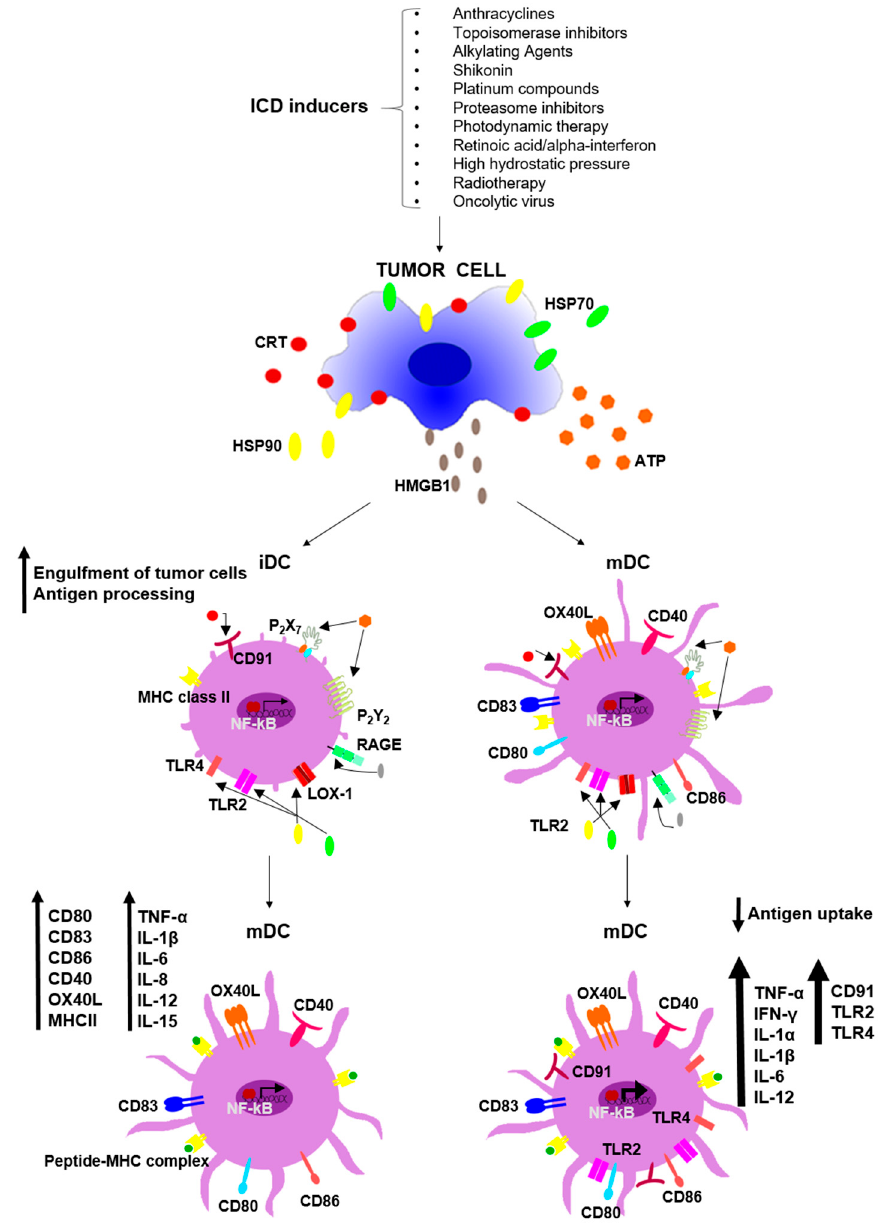
Figure 1. Schematic illustration of ICD-induced damage-associated molecular pattern (DAMP) impact on iDC and mDC. The exposure on the cell surface of CRT, HSP70 and HSP90 favors the engulfment of dying cancer cells by iDC (on the left). The chaperones released in the extracellular environment, together with high-mobility group box 1 (HMGB1) and ATP, promote the maturation of iDC characterized by expression of several surface markers and the release of pro-inflammatory cytokines. Similarly, the released DAMP can bind specific receptors on mDC (on the right), enhancing their activation and their ability to stimulate T-cell mediated immune responses.